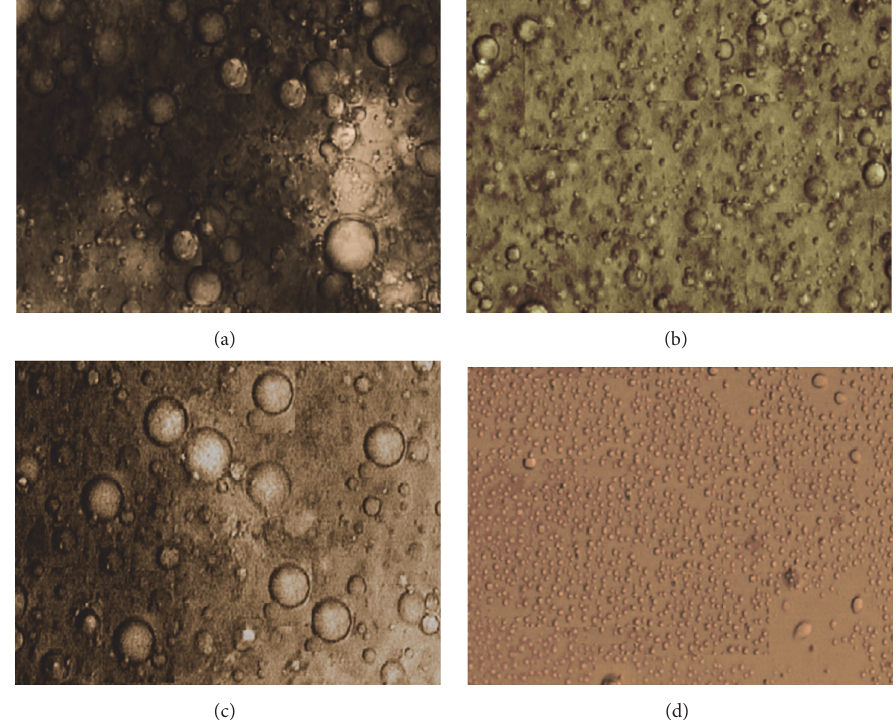
Figure 8: The effect of crude oil demulsification using different methods. (a) Before demulsification; (b) the effect of crude oil demulsification using chemical demulsifier; (c) the effect of crude oil demulsification using ultrasonic treatment; (d) the effect of crude oil demulsification using the combined method of ultrasound and chemical demulsifier.